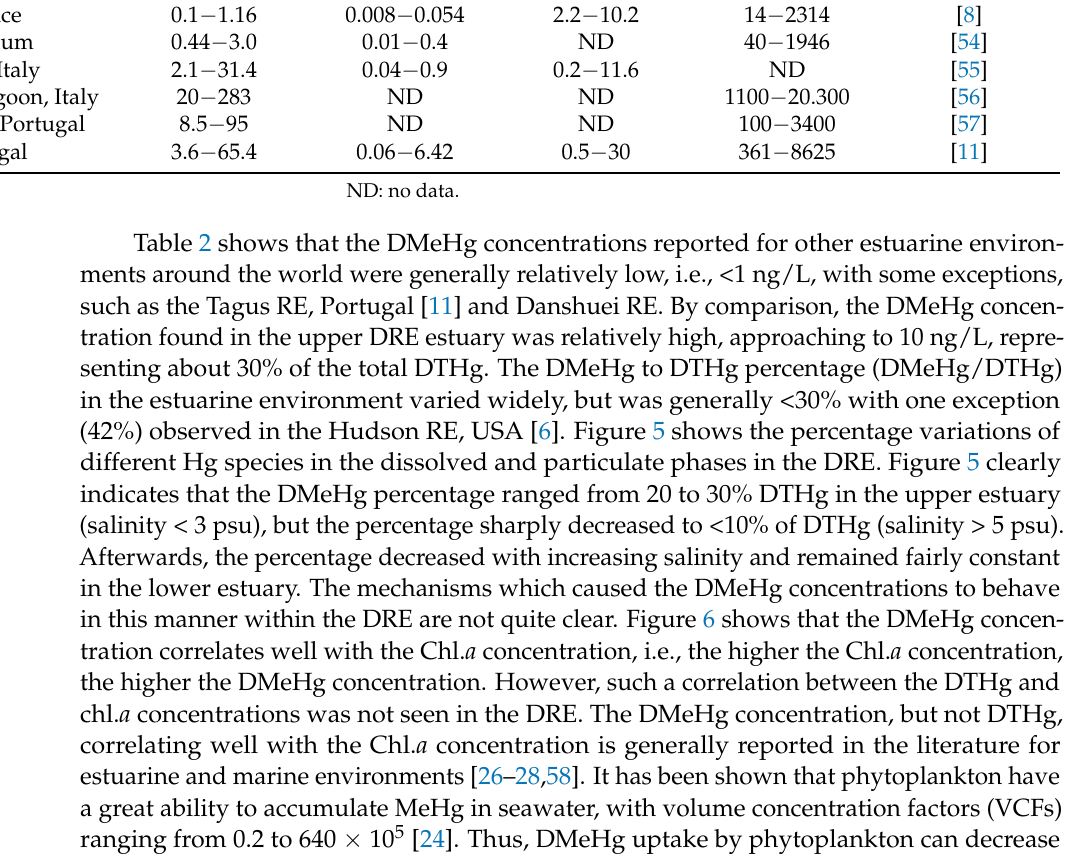
DTHg DMeHg DMeHg/DTHg PTHg (ng/L) (ng/L) (%)